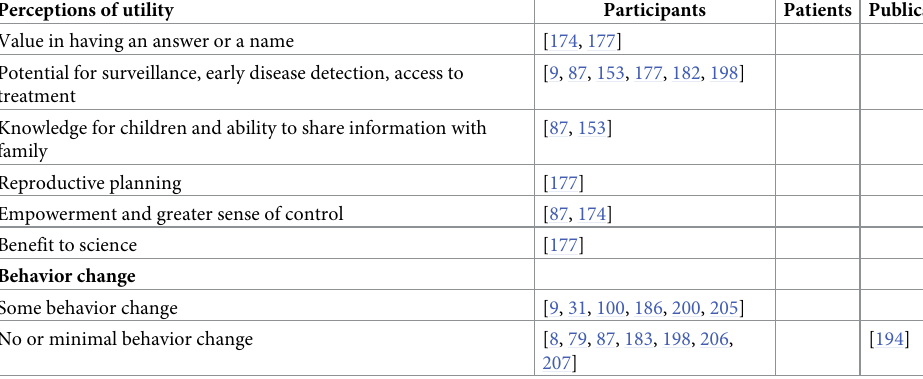
Table 7. Summary of participants’, patients’ and publics’ perceptions of utility and behavioral change. Perceptions of